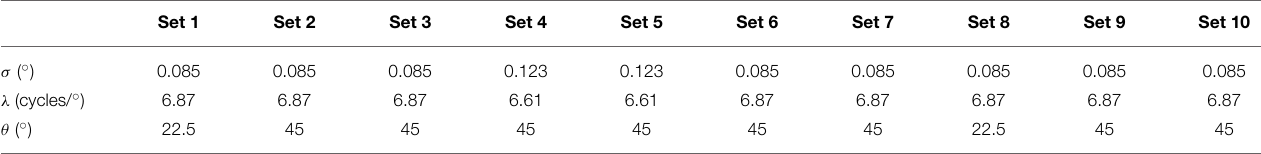
TABLE 2 | Parameters of Gabor filters used in the simulation of the Channel energy observer. Set 1 Set 2 Set 3 Set 4 Set 5 Set 6 Set 7 Set 8 Set 9 Set